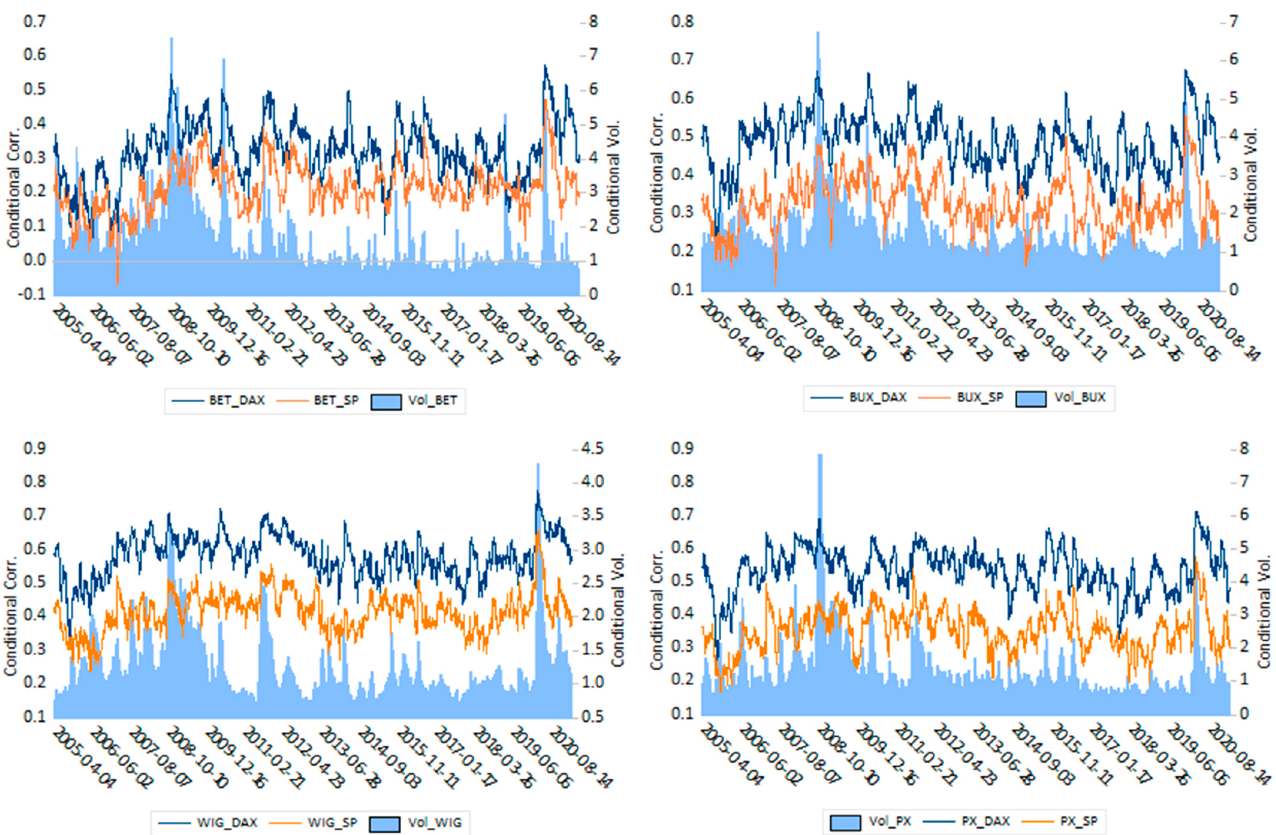
Figure A4. The Estimated Conditional Correlation Coefficients between the Four CEEC Stock Markets and Those in Germany and the US Along with the Conditional Volatilities.